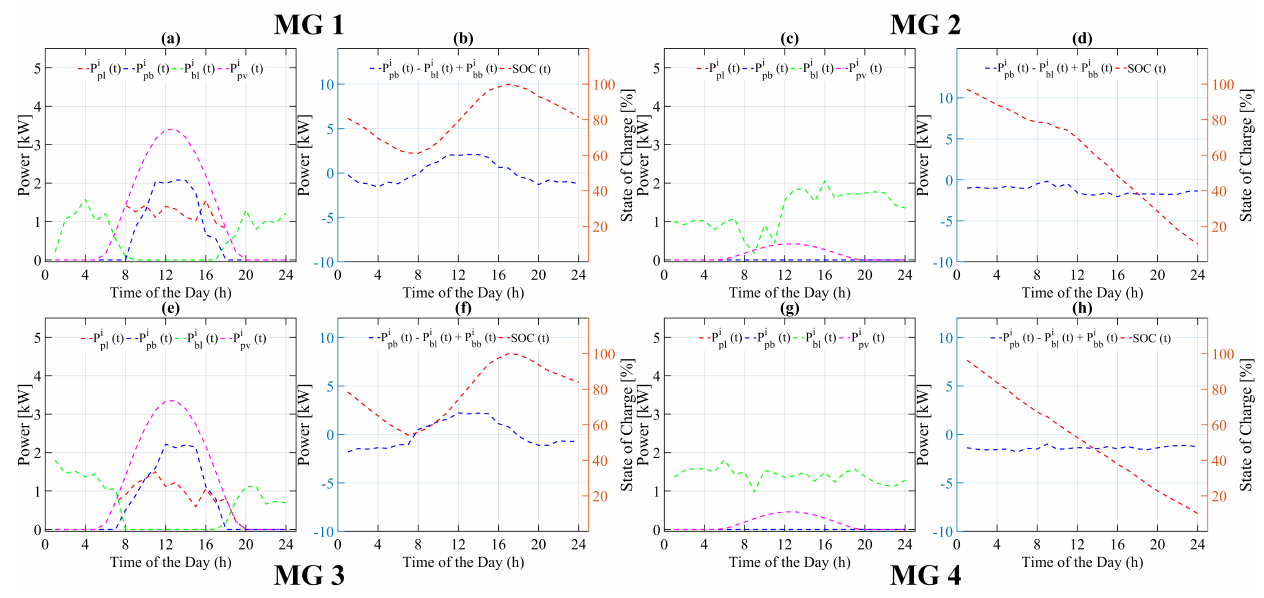
Figure 10. Power flow of various system variable of each microgrid using heuristic state flow based energy management strategy for case C. ( a , c , e , g ) Power flow of PV, battery and Load, ( b , d , f , h ) Battery charging/discharging and state of charge.